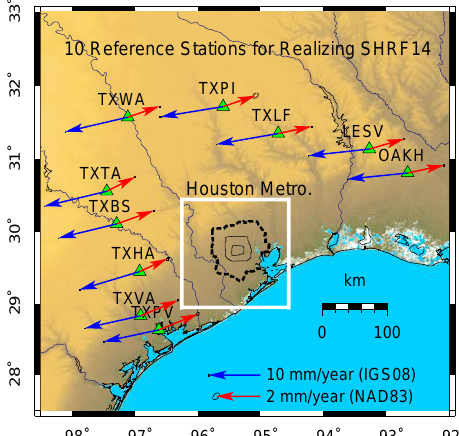
Figure 2. Map showing the locations of 10 reference stations used to realize the Stable Houston Reference Frame of 2014 (SHRF14). The vectors represent the horizontal velocity vectors with respect to IGS08(blue) and NAD83(red). The white box represents the Hous- ton metropolitan